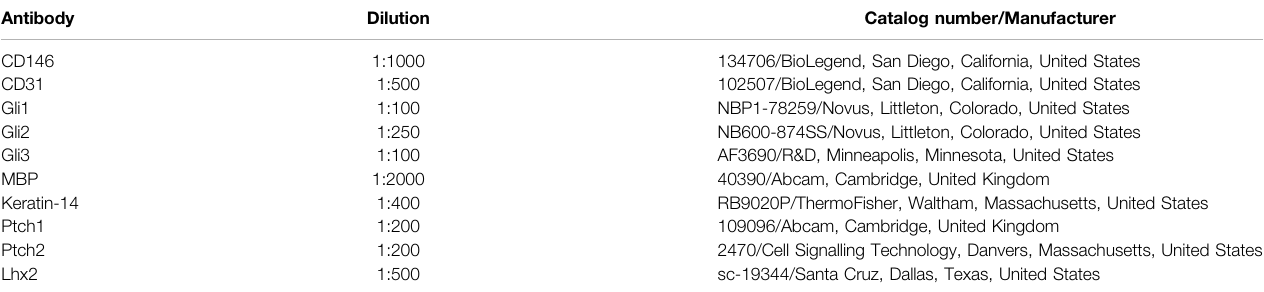
TABLE 1 | List of primary antibodies and dilutions used in the study.